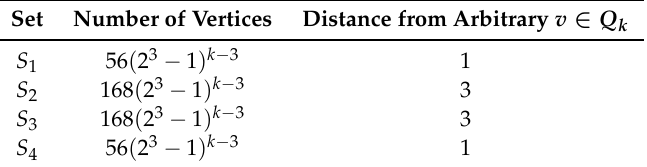
Table 1. Vertex partition of new coming vertices at ( k + 1 ) -th level.